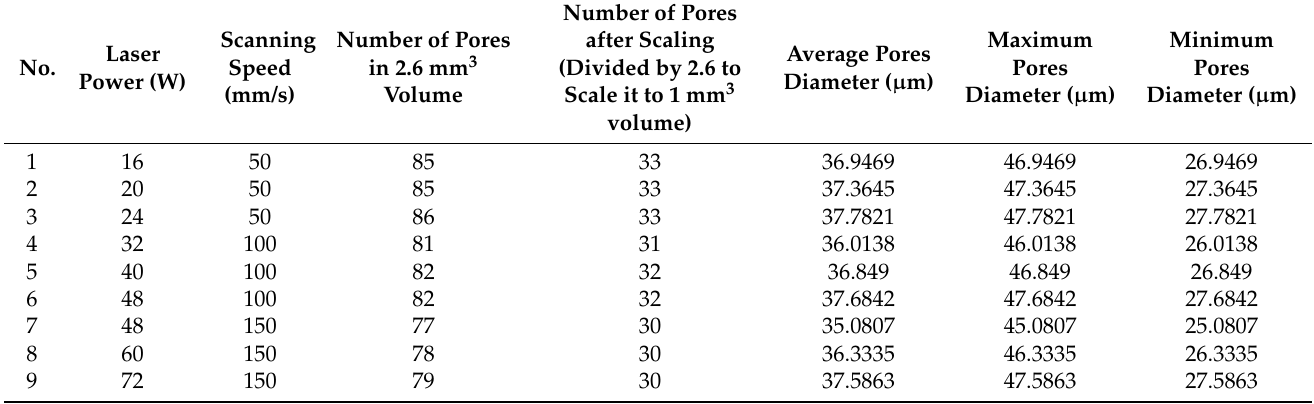
Table 4. Number of pores and pores’ diameter for combined laser power and scanning